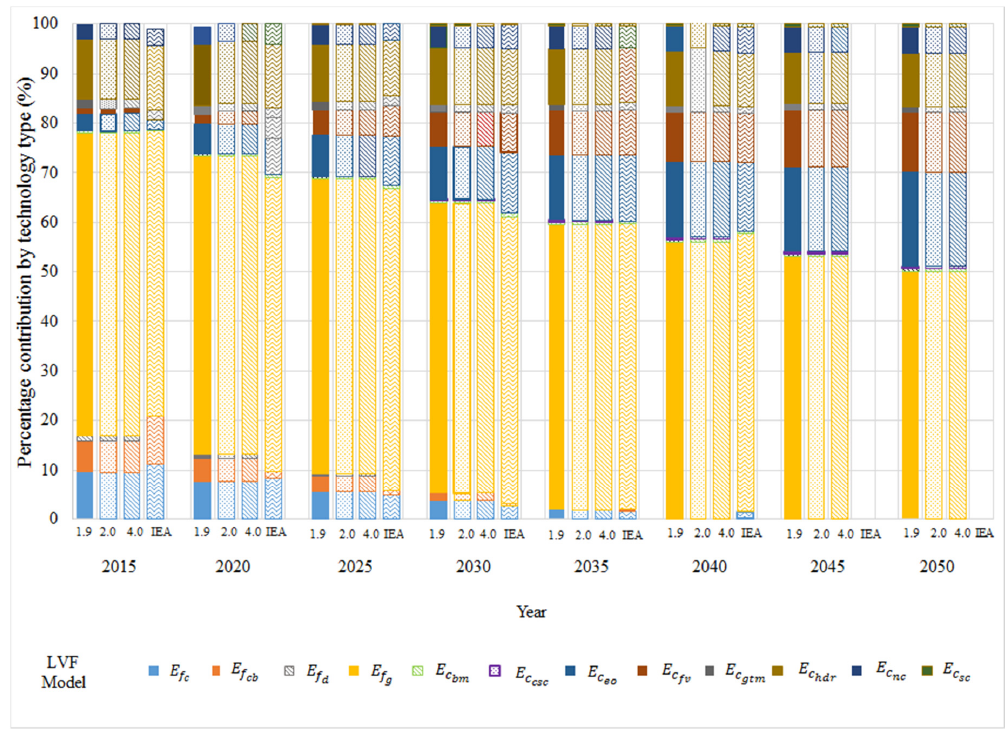
Figure 23. LVF Energy superstructure scenario satisfying governmental objectives from GCCL and National Climate Change Strategy (NCCS) [11,12] compared with IEA scenarios. Prepared by the authors based on own results and public data from cited Reference [18].